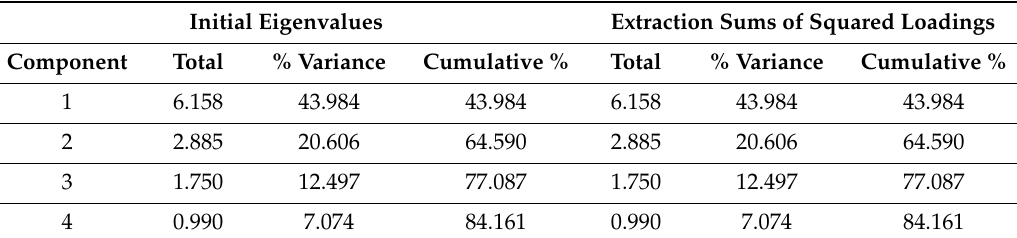
Table 3. Total variance explained by the four extracted components.